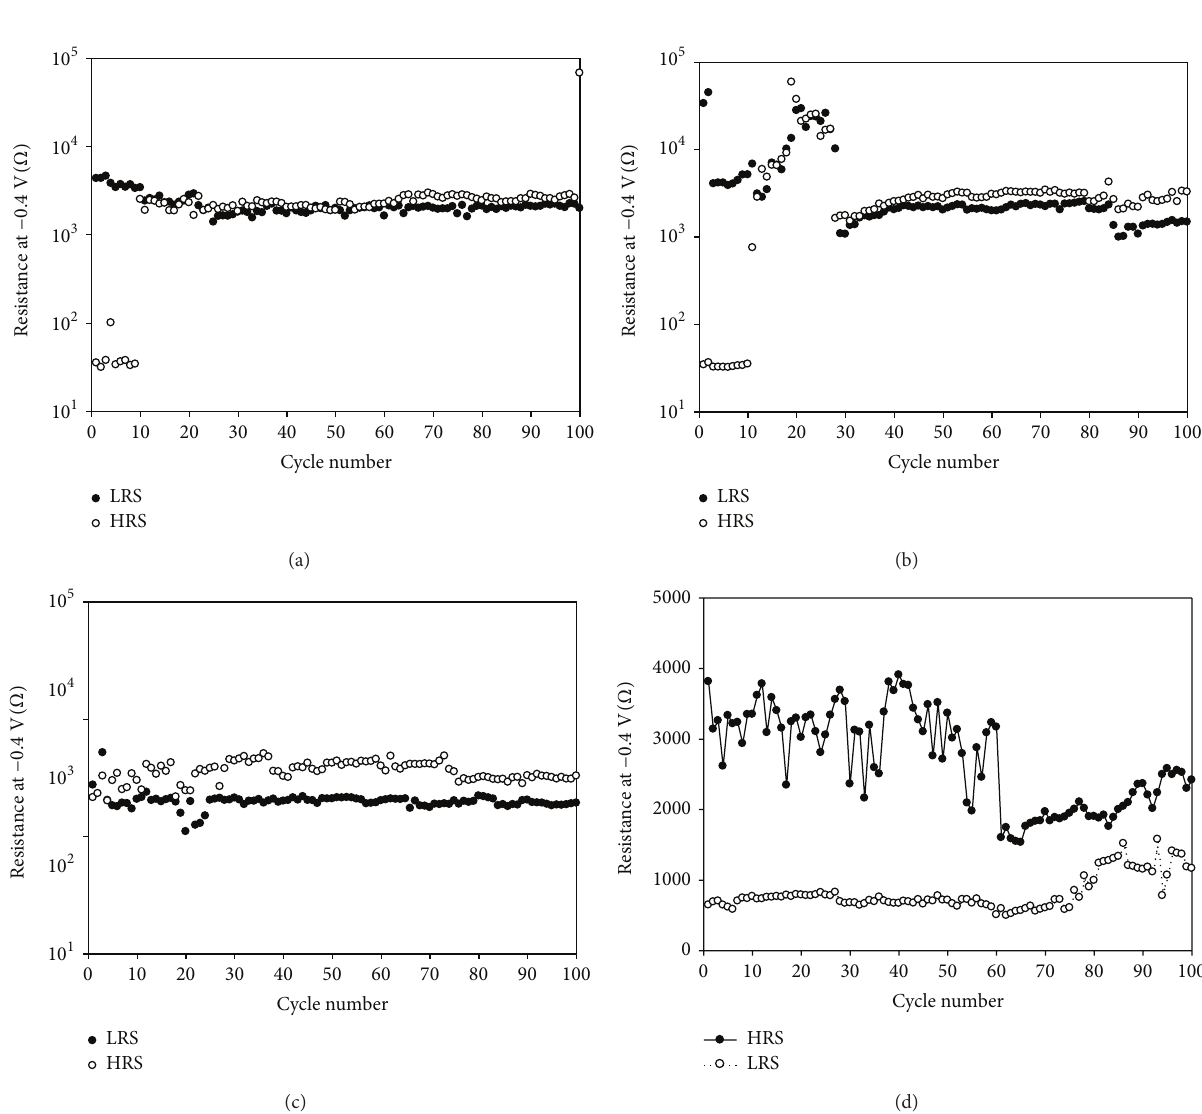
Figure 7: Endurance test of the Al/CBT/ITO/glass cell with different CBT annealing conditions: (a) as-deposited, (b) 450 ∘ C annealed, (c) 500 ∘ C annealed, and (d) 550 ∘ C